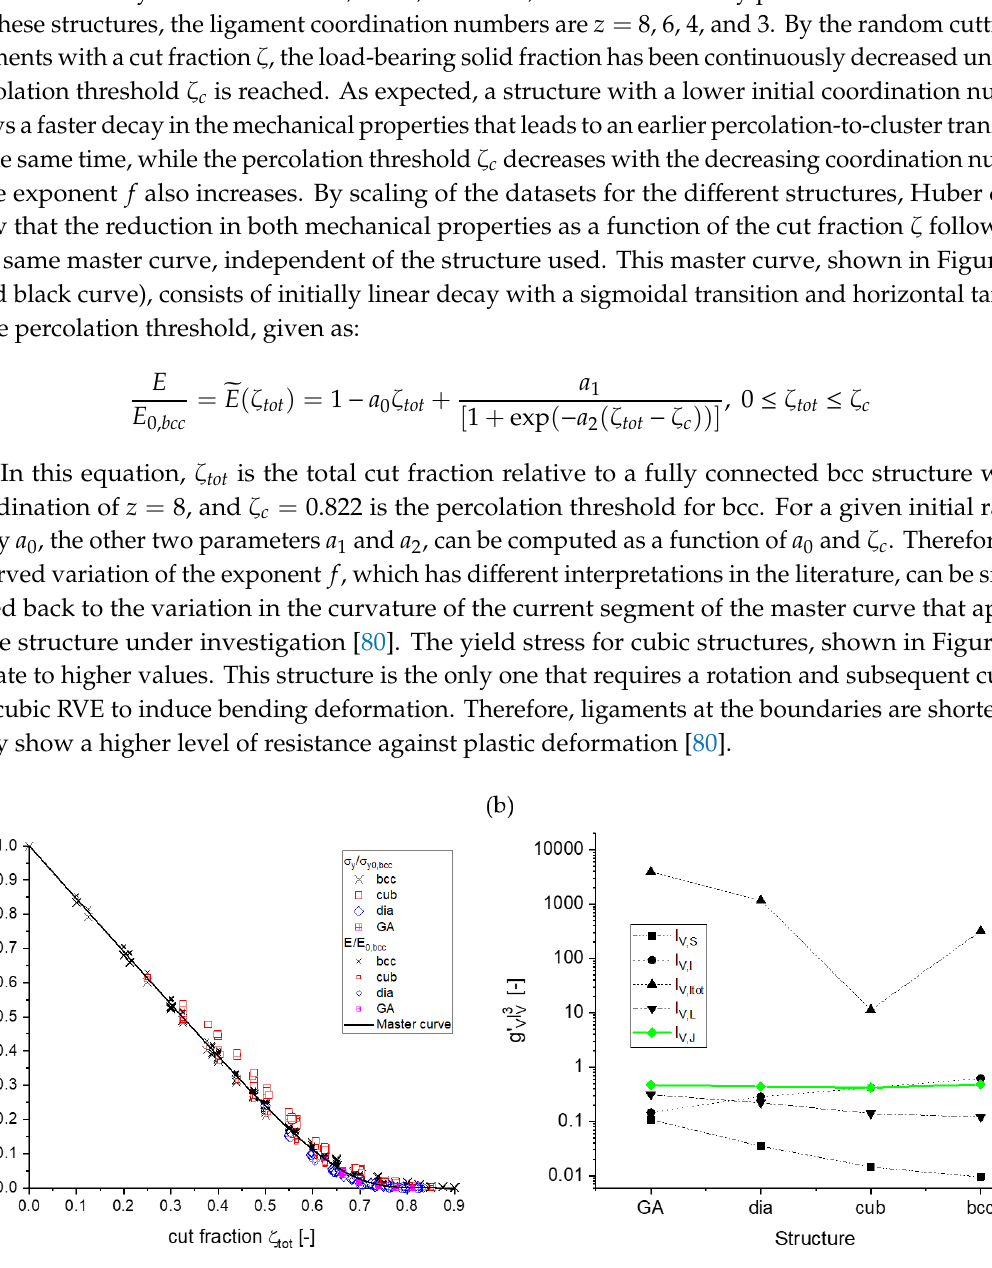
Figure 19. ( a ) The master curve for the macroscopic Young’s modulus and yield stress as a function of the cut fraction (data shown combined supplementary data for both properties provided [80], Data sheet 2) and ( b ) variation of scaled genus density normalized with different characteristic lengths plotted against structures with increasing coordination number. Reprinted from [80], published under Creative Commons Attribution License (CC BY 4.0), own work.